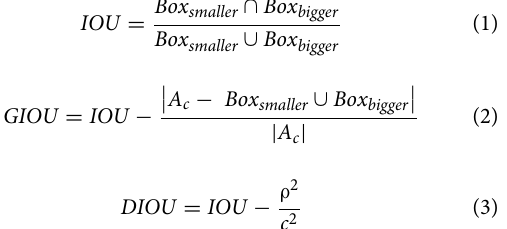
FIGURE5 Examples of two overlapping situations. (A) high density panicles (1,2,3) that should be retained. (B) Repeated detection (4,5) that should be deleted.